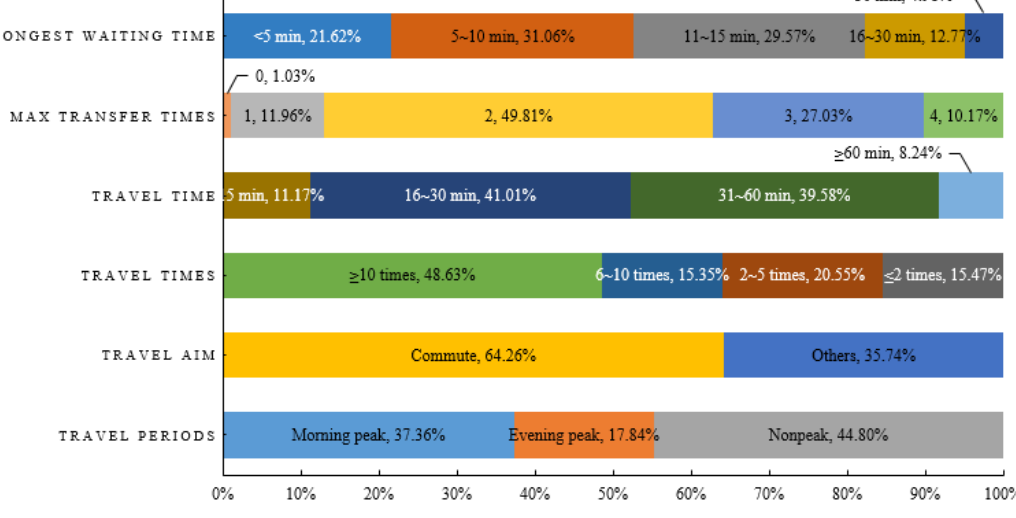
Figure 2. Respondents attribute in the SP survey.